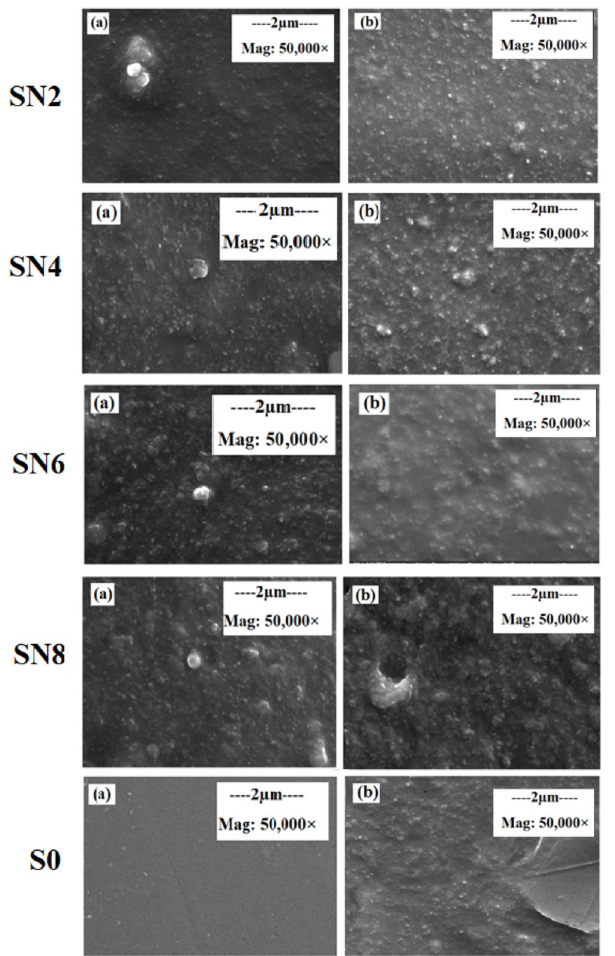
Fig 4. SEM a) Before aging, b) After aging of 9000 hours.